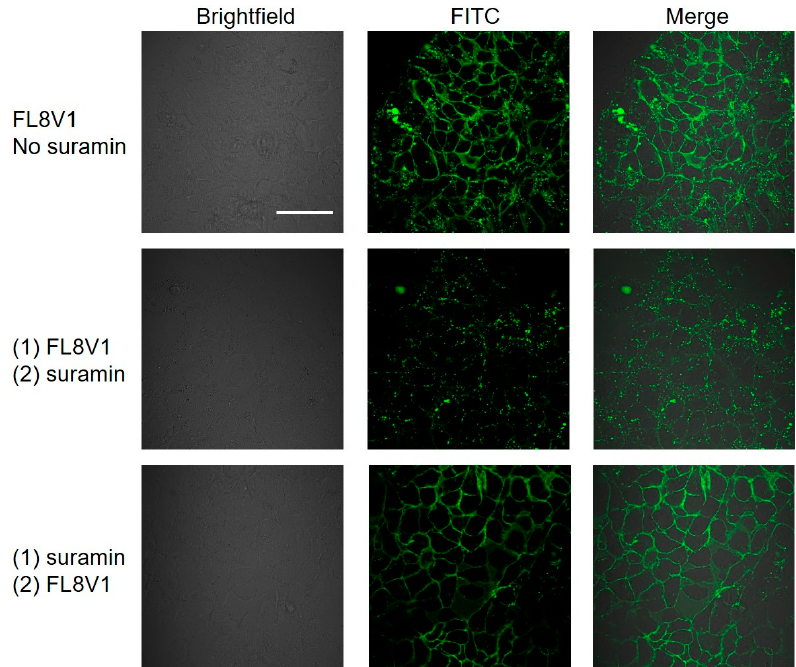
Figure 4. Confocal microscopy images of FL8V1-treated FaDu cells incubated for 30 min with FL8V1 (50 µM) at 37 °C without suramin treatment, post-incubation with suramin, or pre-incubation with suramin; bar represents 50 µm.